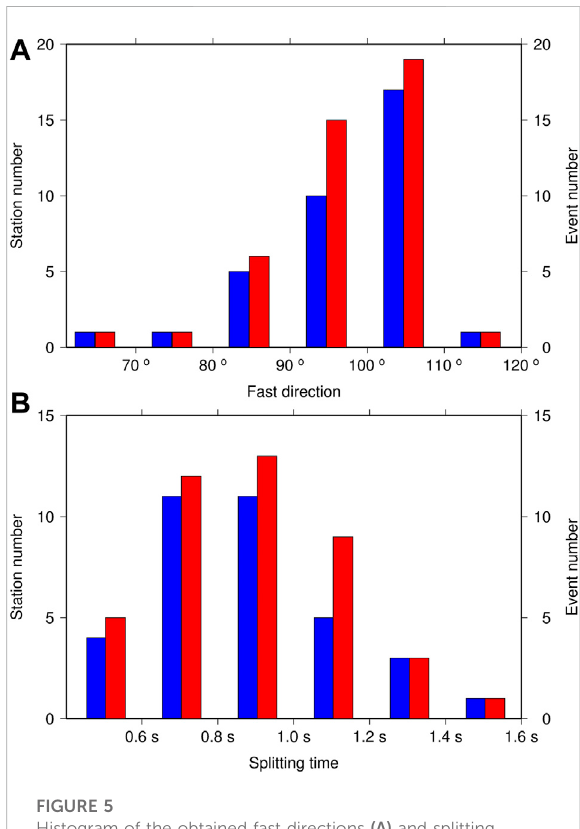
FIGURE 5 Histogram of the obtained fast directions (A) and splitting times (B) in our study region. The blue and red histograms denote the numbers of seismic stations and events, respectively.